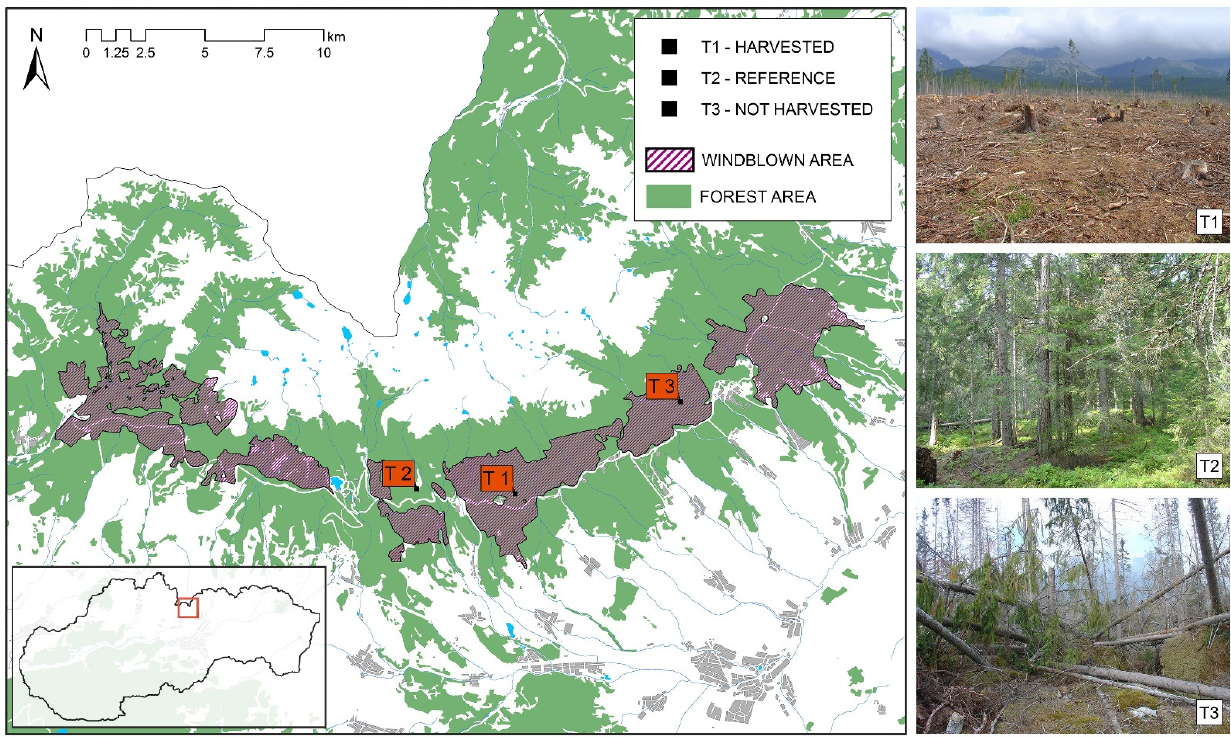
Figure 1. Location of three experimental sites ( T1 , T2 , and T3 ) where 45 topsoil samples were taken. Photographs on the right display the conditions at the three sites two years after the windstorm.